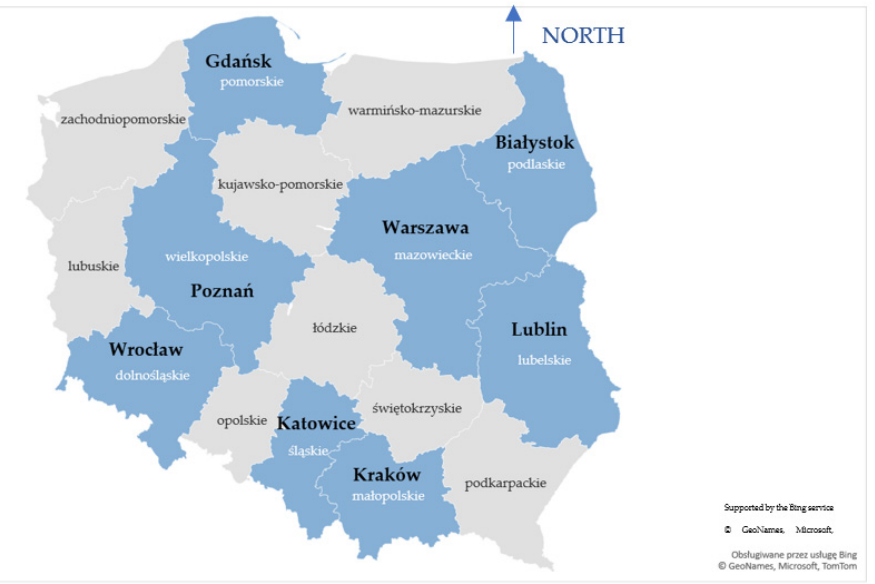
Figure 1. Map of Poland indicating the surveyed cities and provinces (subject of the study). Table 1. Characteristics of the surveyed cities (as of 2021).